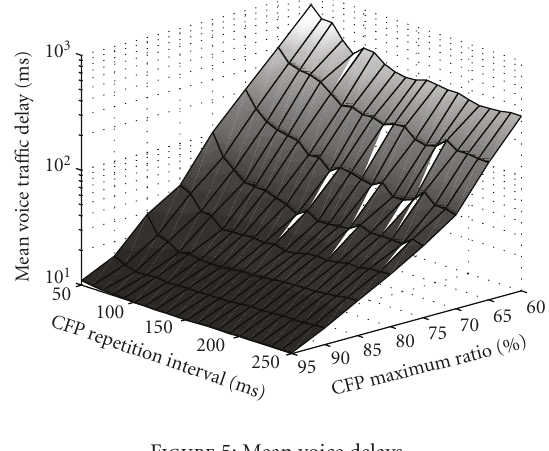
Figure 5: Mean voice